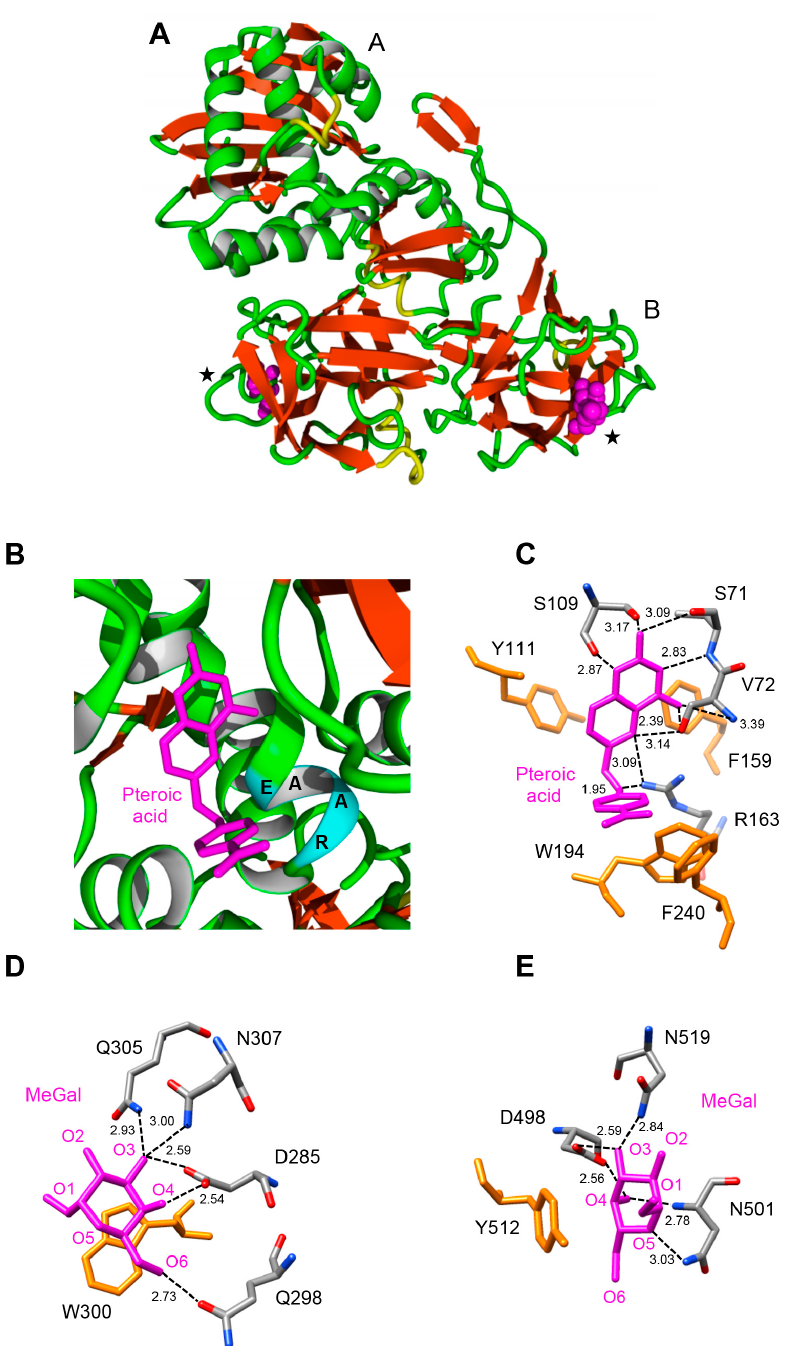
Figure 4. Molecular organization of Md2RIP. ( A ) Ribbon diagram showing the organization of Md2RIP with a RIP (A) and a lectin (B) domain. Stars show the position of the carbohydrate-binding sites in the lectin domain; ( B ) Docking of pteroic acid (magenta stick) into the active site of the RIP domain, showing the EAAR sequence of the active site; ( C ) Network of H-bonds (dashed lines) anchoring pteroic acid to the active site of the RIP domain. H-bond distances are expressed in angström (Å). Aromatic residues developing a stacking interaction with pteroic acid are colored orange; ( D , E ) Network of hydrogen bonds (dashed lines) anchoring MeGal (magenta stick) to the amino acid residues (atom-code colored sticks) forming the carbohydrate-binding sites 1 ( D ) and 2 ( E ) of Md2RIP lectin domain. Aromatic residues interacting through a stacking with the pyranose ring of MeGal in both sites are colored